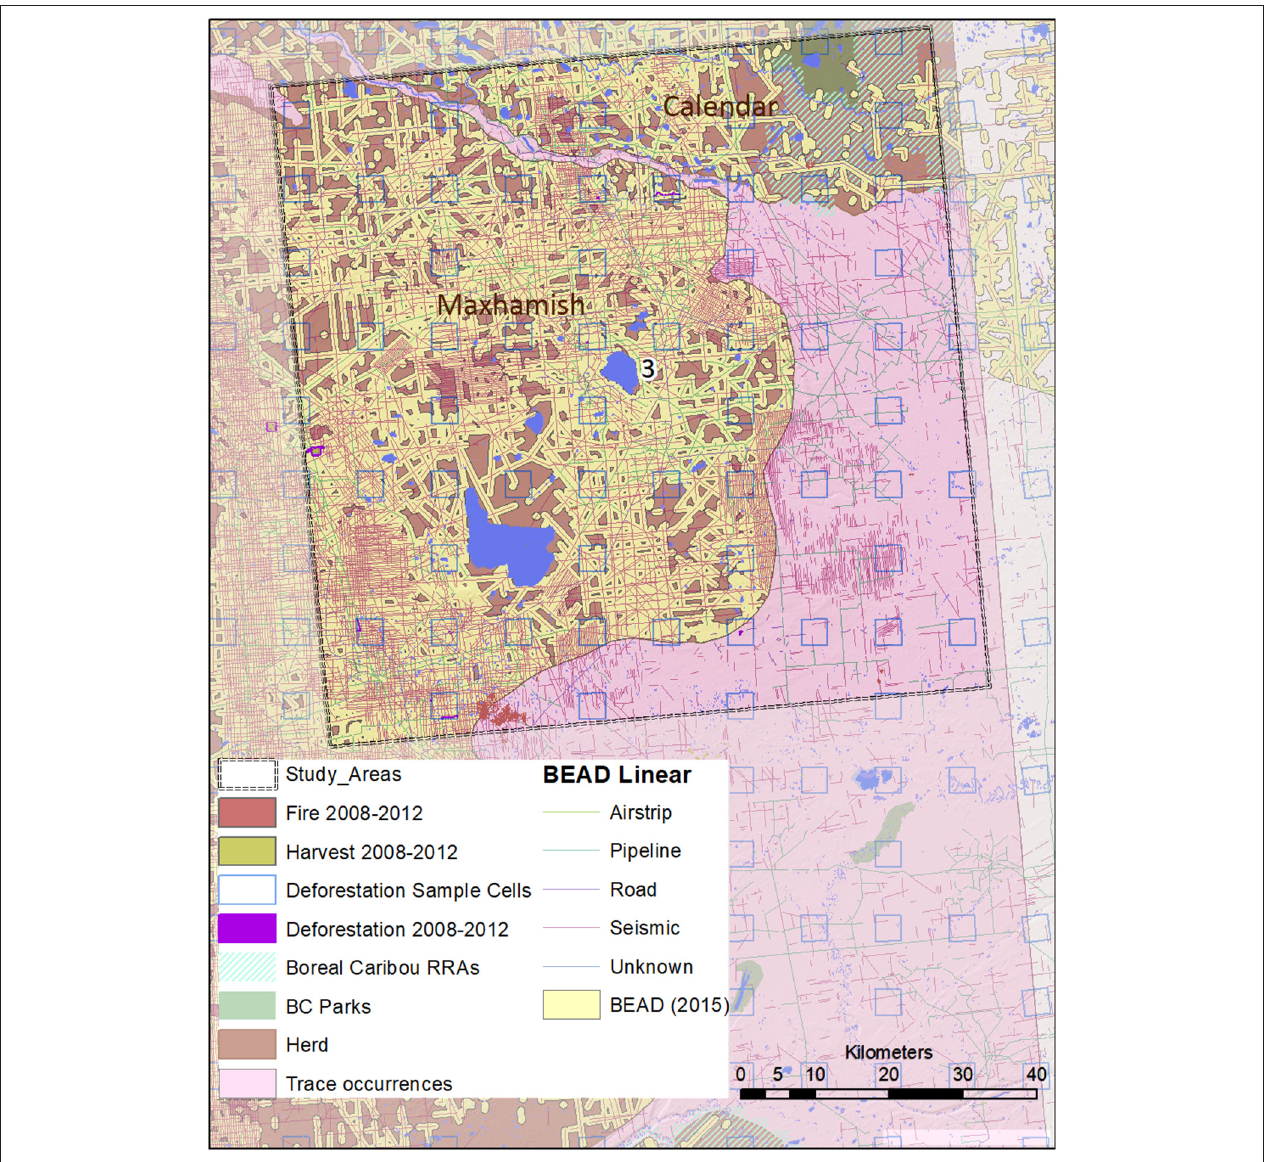
FIGURE 5 | A map of natural and anthropogenic disturbances, deforestation sample cells, and linear features in Study Area 3, associated with the Snake-Sahtahneh and Calendar caribou herds. Linear features are those included in the Boreal Ecosystem Anthropogenic Disturbance (BEAD) vector database corresponding to 2008 to 2010 Landsat imagery.